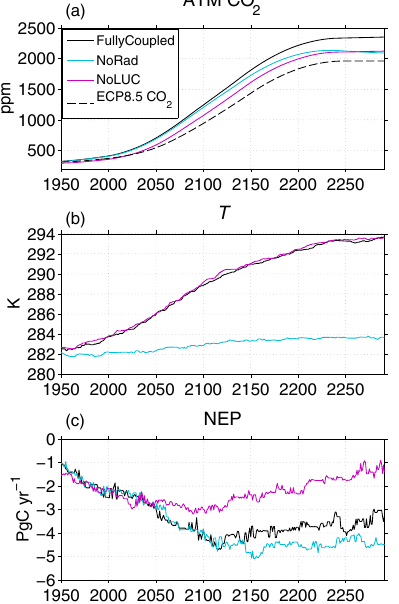
Figure 6. (a) Annual mean atmospheric CO 2 , (b) annual mean bottom-level atmospheric T over land, and (c) annual mean NEP averaged over the NH (0–90 ◦ N) in the CESM FullyCoupled (solid black curves), NoRad (blue curves), and NoLUC (magenta curves) simulations. Negative NEP indicates net annual CO 2 uptake by the land surface. Values are filtered using a 10-year running median. The CO 2 mole fraction values in (a) result from the net contribu- tions of land, ocean, and fossil fuel tracers calculated from NEE as described in Sect. 2.3, and they differ from the atmospheric CO 2 mixing ratio that is prescribed according to the ECP8.5 scenario (dashed black curve).